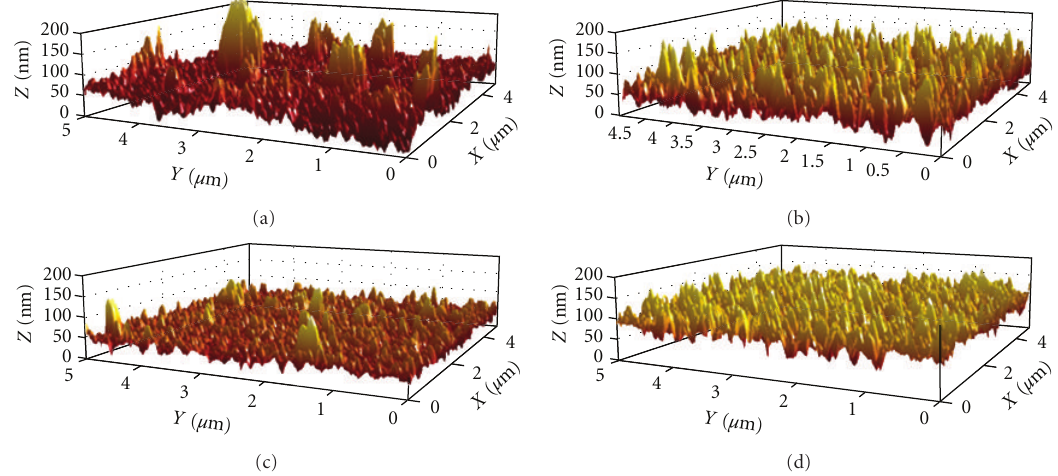
Figure 4: 3D AFM images (5 × 5 μ m 2 ) of as-grown films of In 2 S 3 deposited at di ff erent substrate temperature (a) 272 ◦ C, (b) 300 ◦ C, (c) 323 ◦ C, and (d) 340 ◦ C.